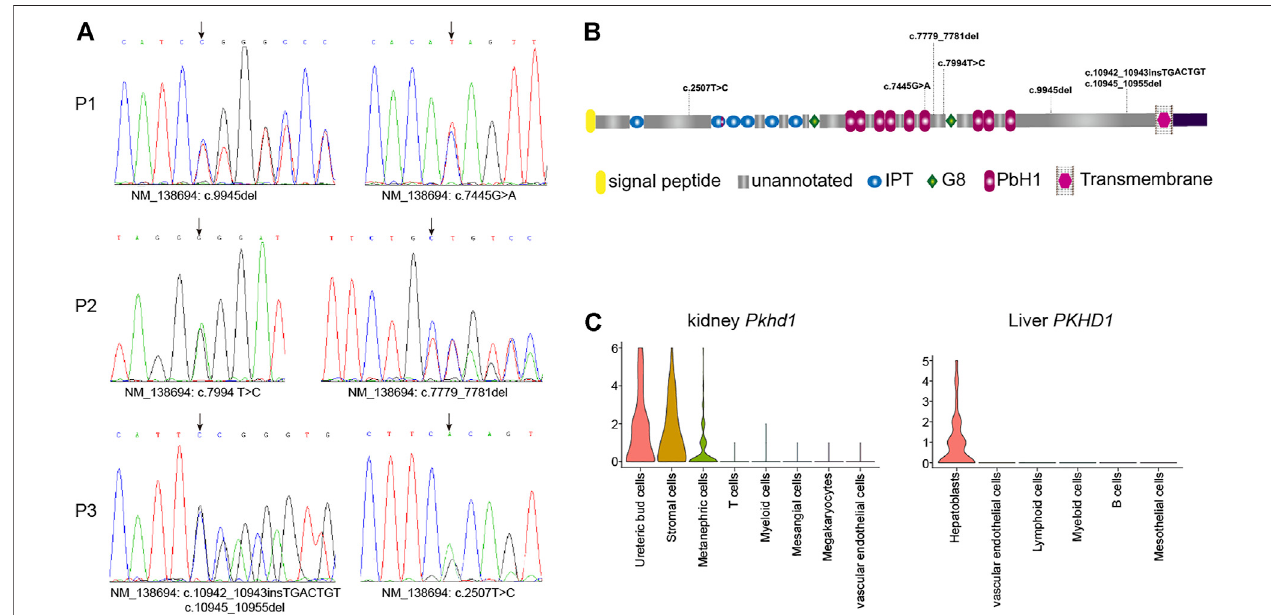
FIGURE 2 | Gene mutations analysis of PKHD1 . (A) The rare putative pathogenic variants in PKHD1 were validated by Sanger sequencing. (B) Schematic representation ofvariantdistributionsinthe PKHD1 domain. (C) Violin plotof PKHD1 expression inmouse kidney andhumanlivertissues byscRNA-seq analysis. TheY axis was normalized expression level for PKHD1 in different